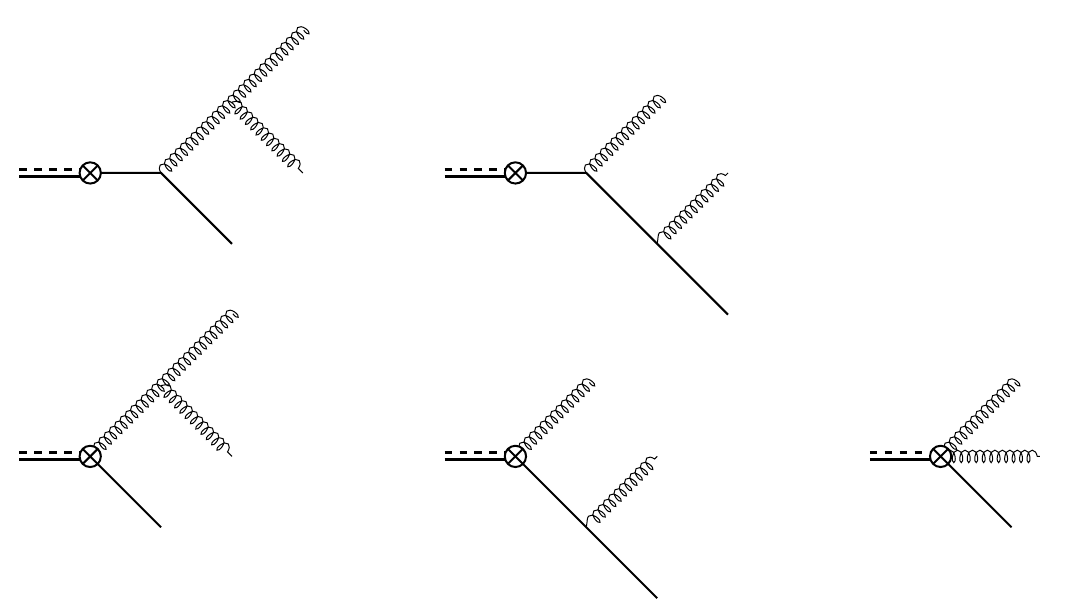
Figure 5 . Feynam diagrams contributing to the boundary contributions of five-point QCD ampli- tude under gluon-quark